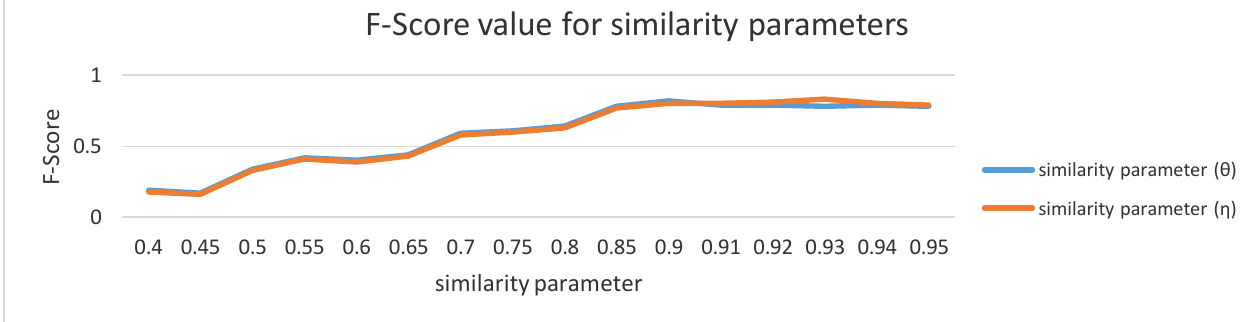
Figure 6. Average similarity parameter against